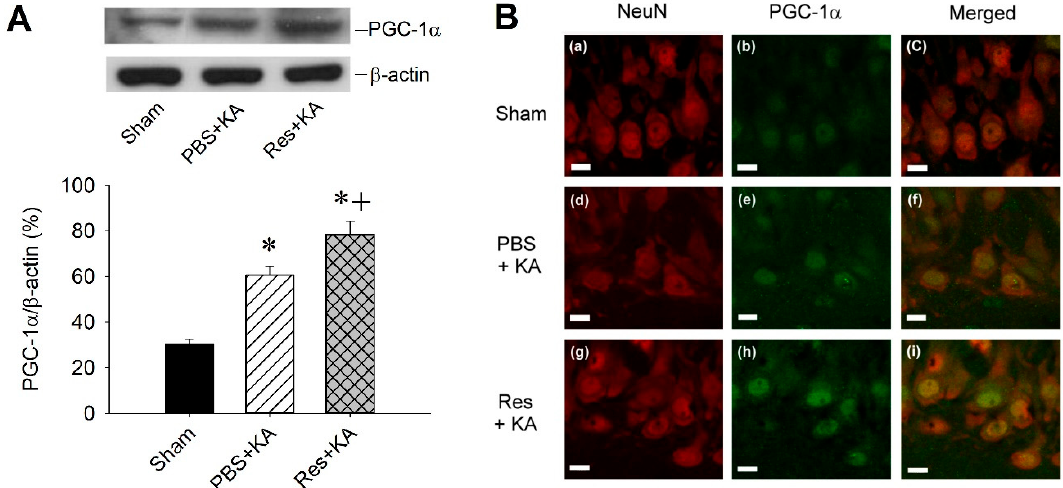
Figure 3. ( A ) Representative gels (inset) or changes in PGC-1 α relative to β -actin from CA3 subfield of hippocampus 6 h after microinjection of 0.5 nmol kainic acid (KA) or pretreatment with microinjection of PGC-1 α activator, resveratrol (Res; 100 µ mol) into hippocampal CA3 subfield. Values are mean ± SEM of quadruplicate analyses from six animals per experimental group. * p < 0.05 versus sham control group, + p < 0.05 versus PBS + KA group in the Scheff é multiple-range test. ( B ) Laser scanning confocal microscopic images of right CA3b subregion of hippocampus showing cells immunoreactive to a neuronal marker, NeuN (red fluorescence), or additionally stained for PGC-1 α (green fluorescence) from sham animals (a–c), or 6 h after microinjection of 0.5 nmol KA (d–f) or pretreatment with microinjection of resveratrol (Res; 100 µ mol) before KA into the hippocampal CA3 subfield (g–i). Scale bar, 10 µm.